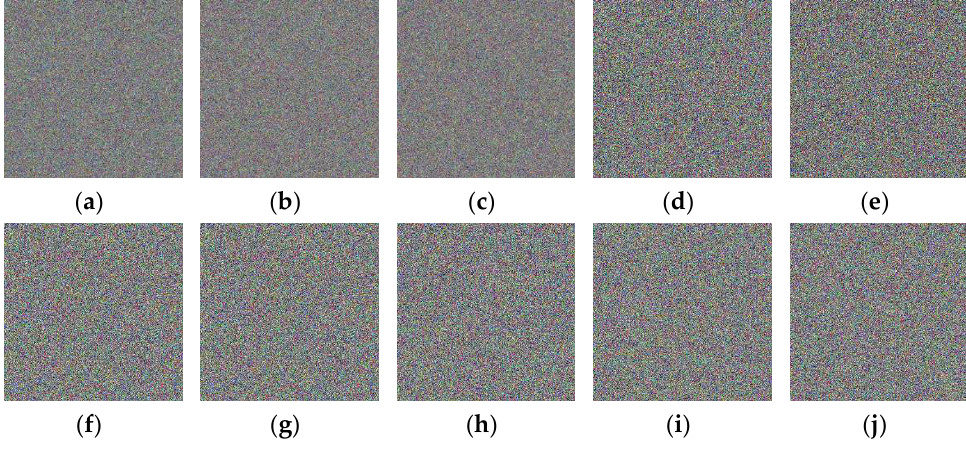
Figure 13. Color encrypted images: ( a ) Peppers; ( b ) Baboon; ( c ) Airplane; ( d ) House; ( e ) Penguin; ( f ) Sky; ( g ) Railway; ( h ) Sea; ( i ) Water; ( j ) Building.